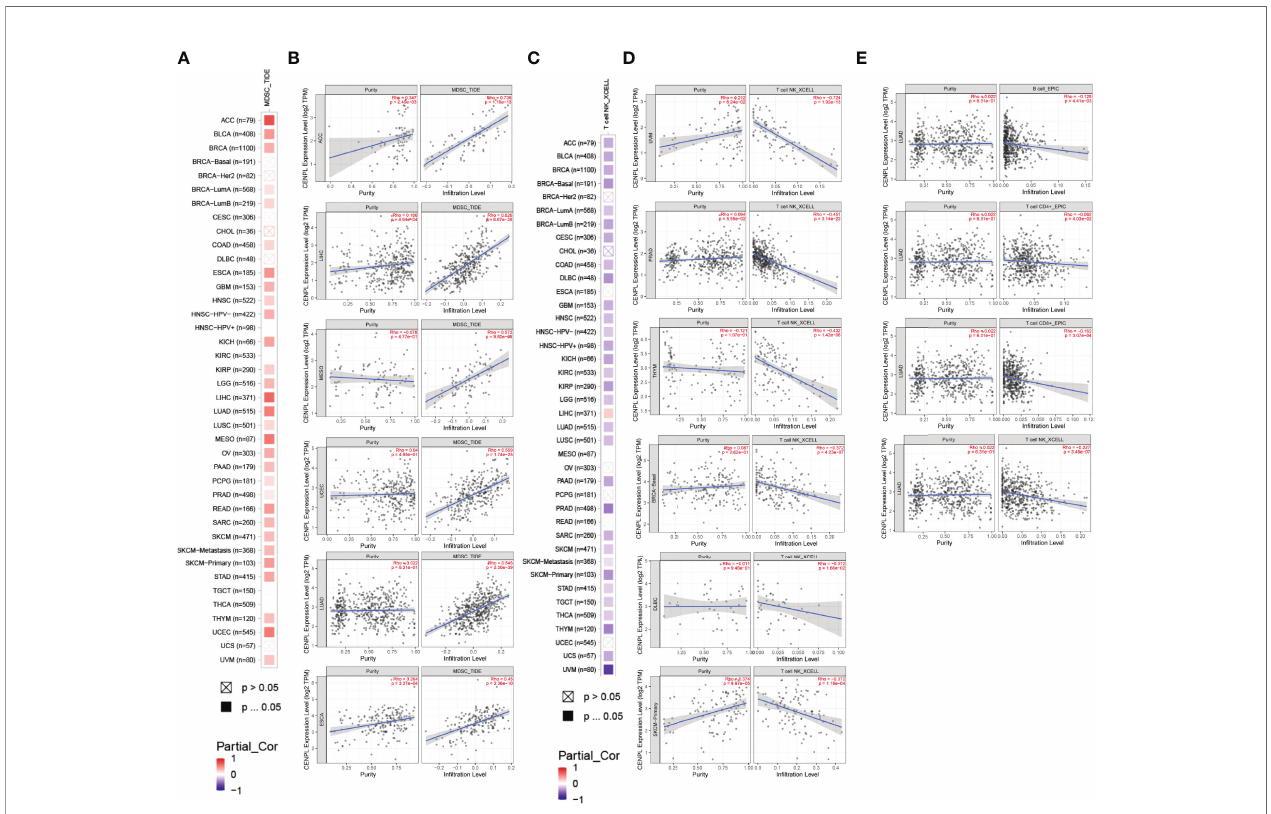
FIGURE 5 | The association between CENPL expression and immune cell in fi ltration. (A, B) CENPL expression is positively associated with MDSC in fi ltration in pan- cancer. (C, D) CENPL expression is negatively associated with NKT cell in fi ltration in pan-cancer. (E) CENPL expression is negatively associated with the in fi ltration level of B cells, CD4 + T cells, CD8 + T cells, and NKT